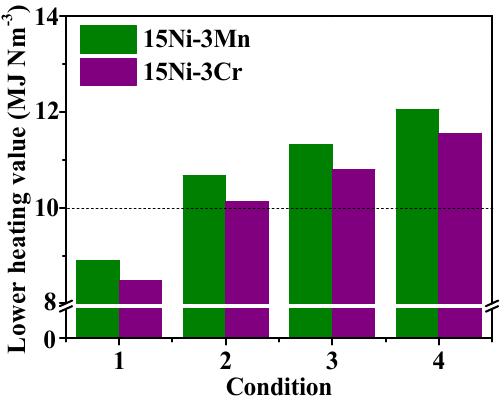
Figure 9. Lower heating value of biomass gas under different conditions. Condition 1 refers to the outlet state after partial methanation coupling with WGS at 350 °C, H 2 /CO = 0.8 and H 2 O/CO = 1. Conditions 2–4 refer to the assumed state, for which 30%, 40% and 50% CO 2 is removed, respectively.